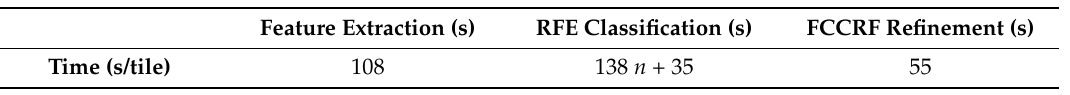
Time costs at different stages of the proposed classification pipeline for a tile of 2000 × 2500